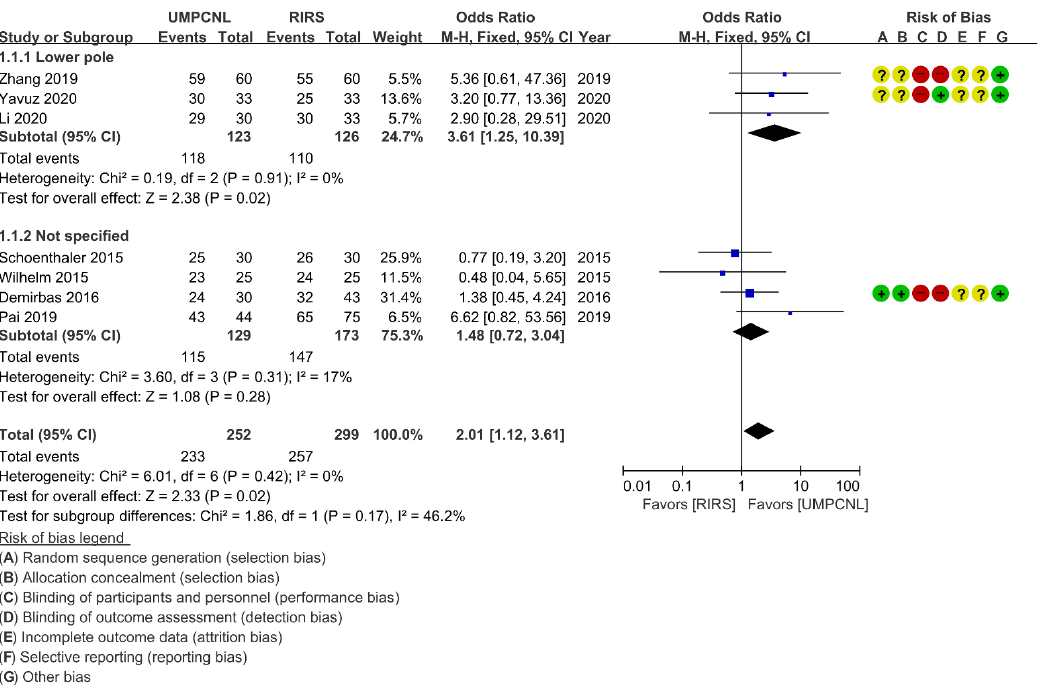
Figure 3. Comparison of ultra-mini percutaneous nephrolithotomy (UMPCNL) and retrograde intrarenal surgery (RIRS) in terms of the SFR.